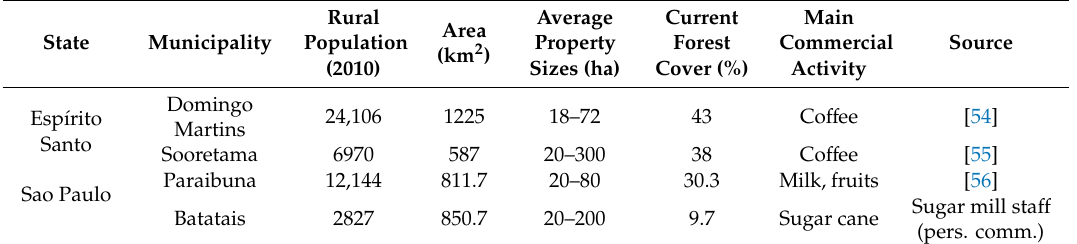
Table 2. Characteristics of the four landscapes where interviews with state and local actors were conducted. Current forest cover includes remnants, secondary and restored forest.